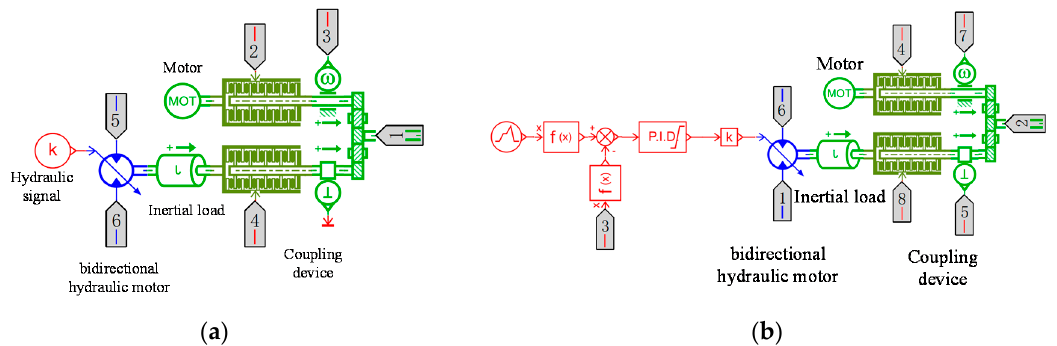
Figure 7. Internal structure of the MEH-DCDS: ( a ) is the MEH-DCDS model, and ( b ) is the MEH-DCDS model under PID control.